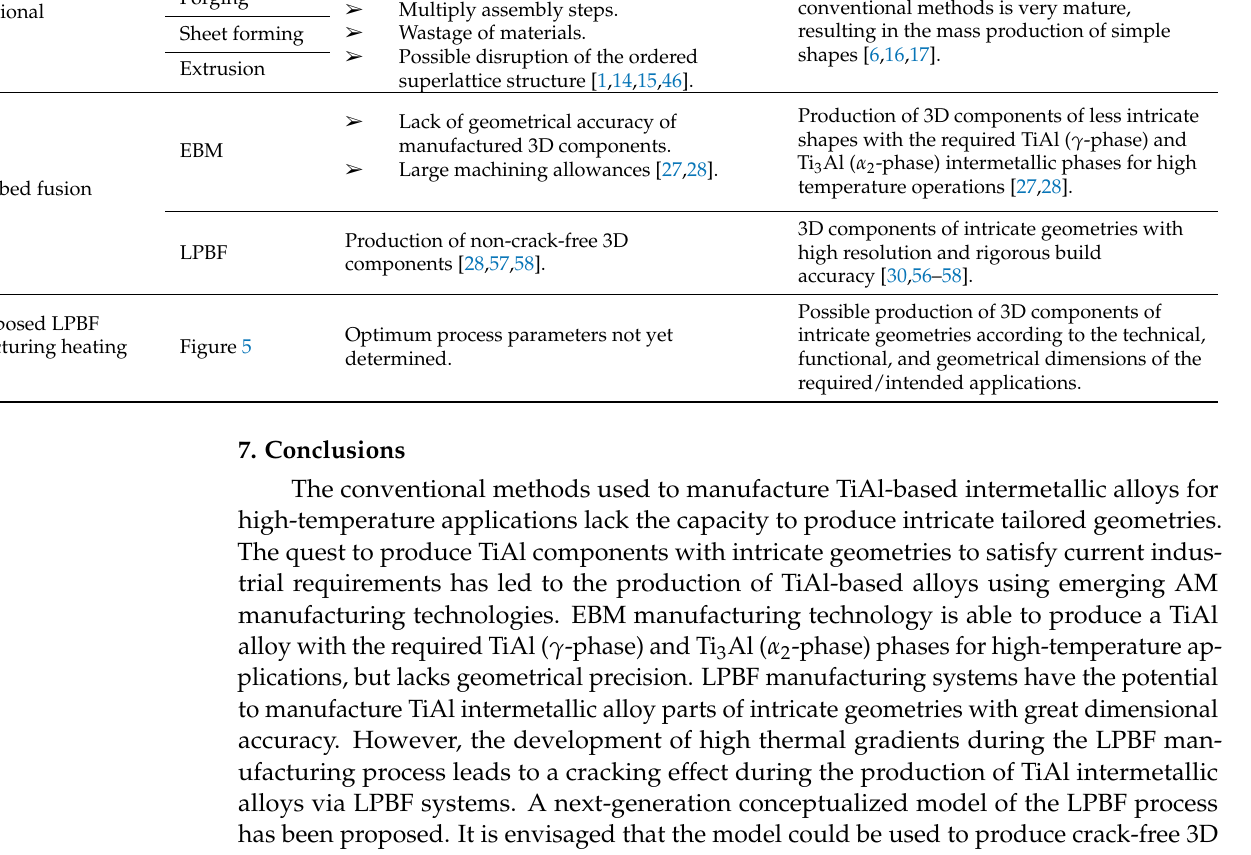
Table 1. Conventional and PBF manufacturing methods.